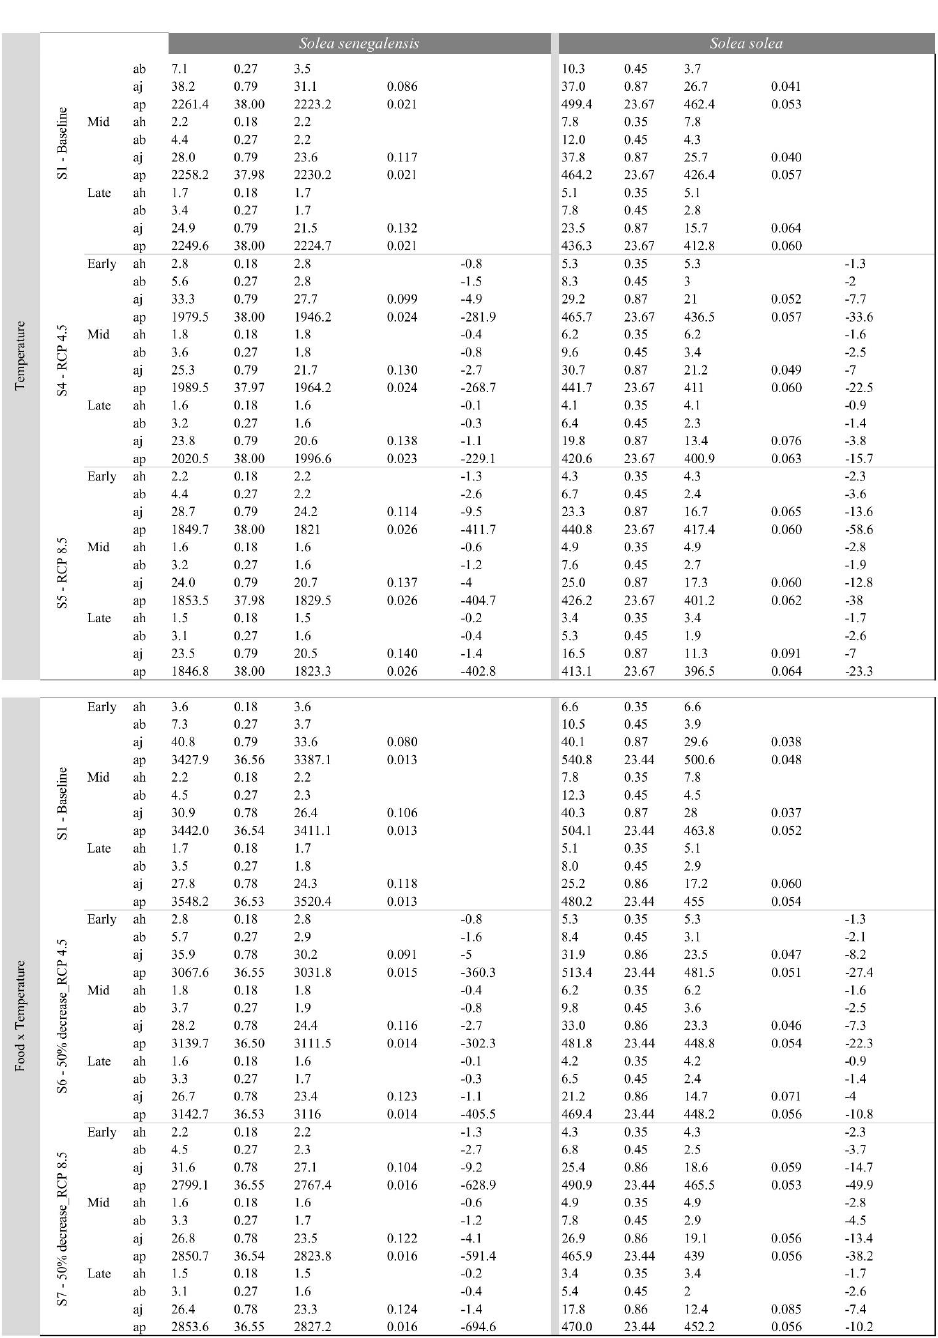
Figure A5. Predicted age and size at different stages, stage duration and growth rates for Solea spp. for the evaluated effects of temperature and food availability. In total, we simulated seven scenarios (S1–S7), with three spawning events (early-mid-late) in each. Scenarios were designed to reflect potential changes in food availability and increase in temperature (warming of 1.8 and 3.7 degrees—RCP 4.5 and RCP 8.5, respectively, IPCC, 2014), both relative to the baseline, i.e., cur- rent conditions. Current (baseline) food availability (X) is assumed to result in scaled functional response f = 0.85 in both species, and temperature is assumed to reflect the average seasonal fluc- tuations in typical coastal sea and estuaries inhabited by soles (please see Methods of main text for more